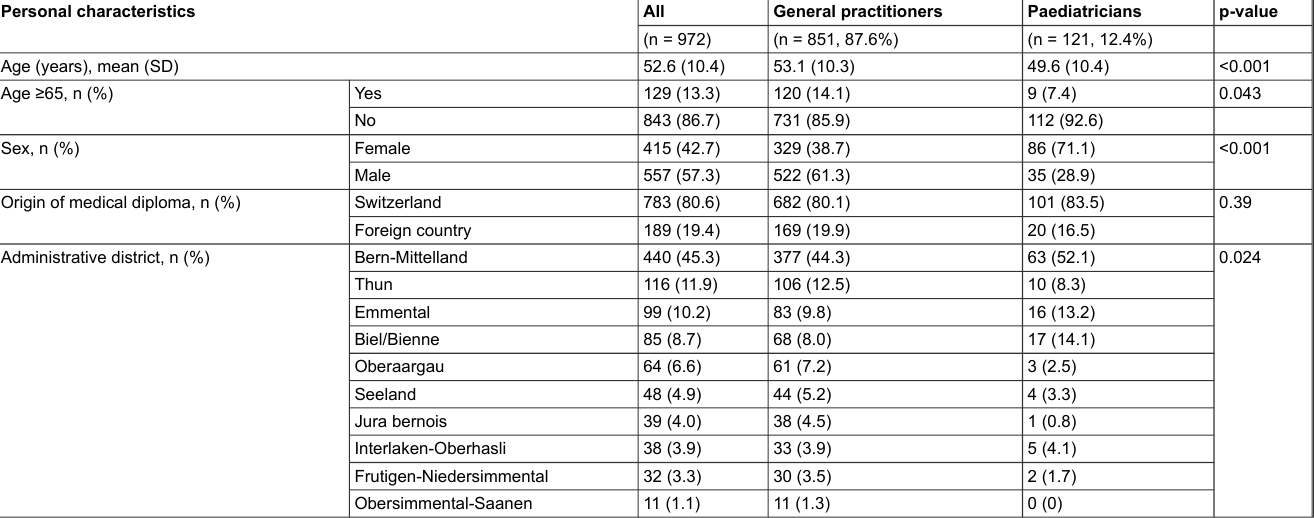
Table 1: Personal characteristics of primary care physicians in the Canton of Bern in 2020. Personal characteristics